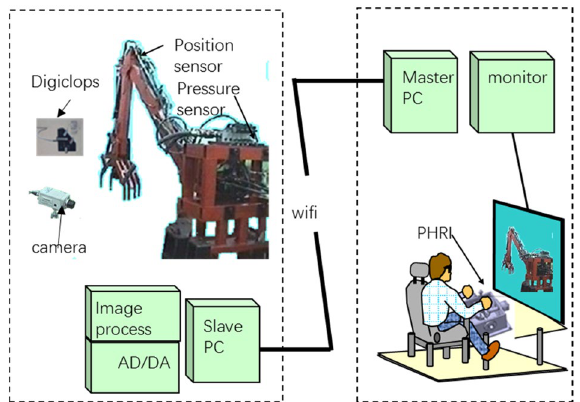
Figure 1. Teleoperation system.